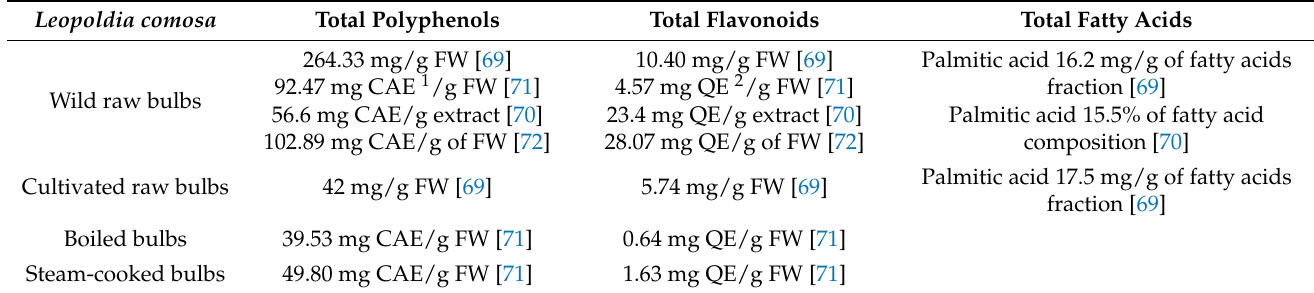
Table 5. Some examples of polyphenol and fatty acid content in L. comosa .